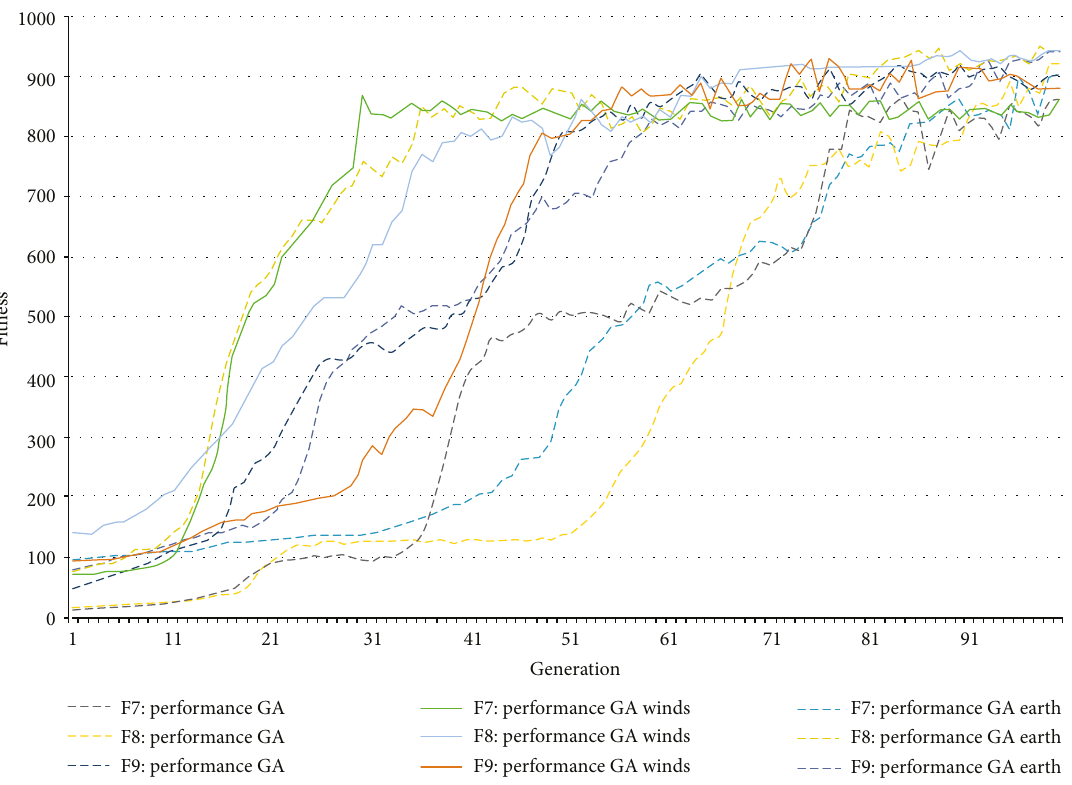
Figure 6: Wind time